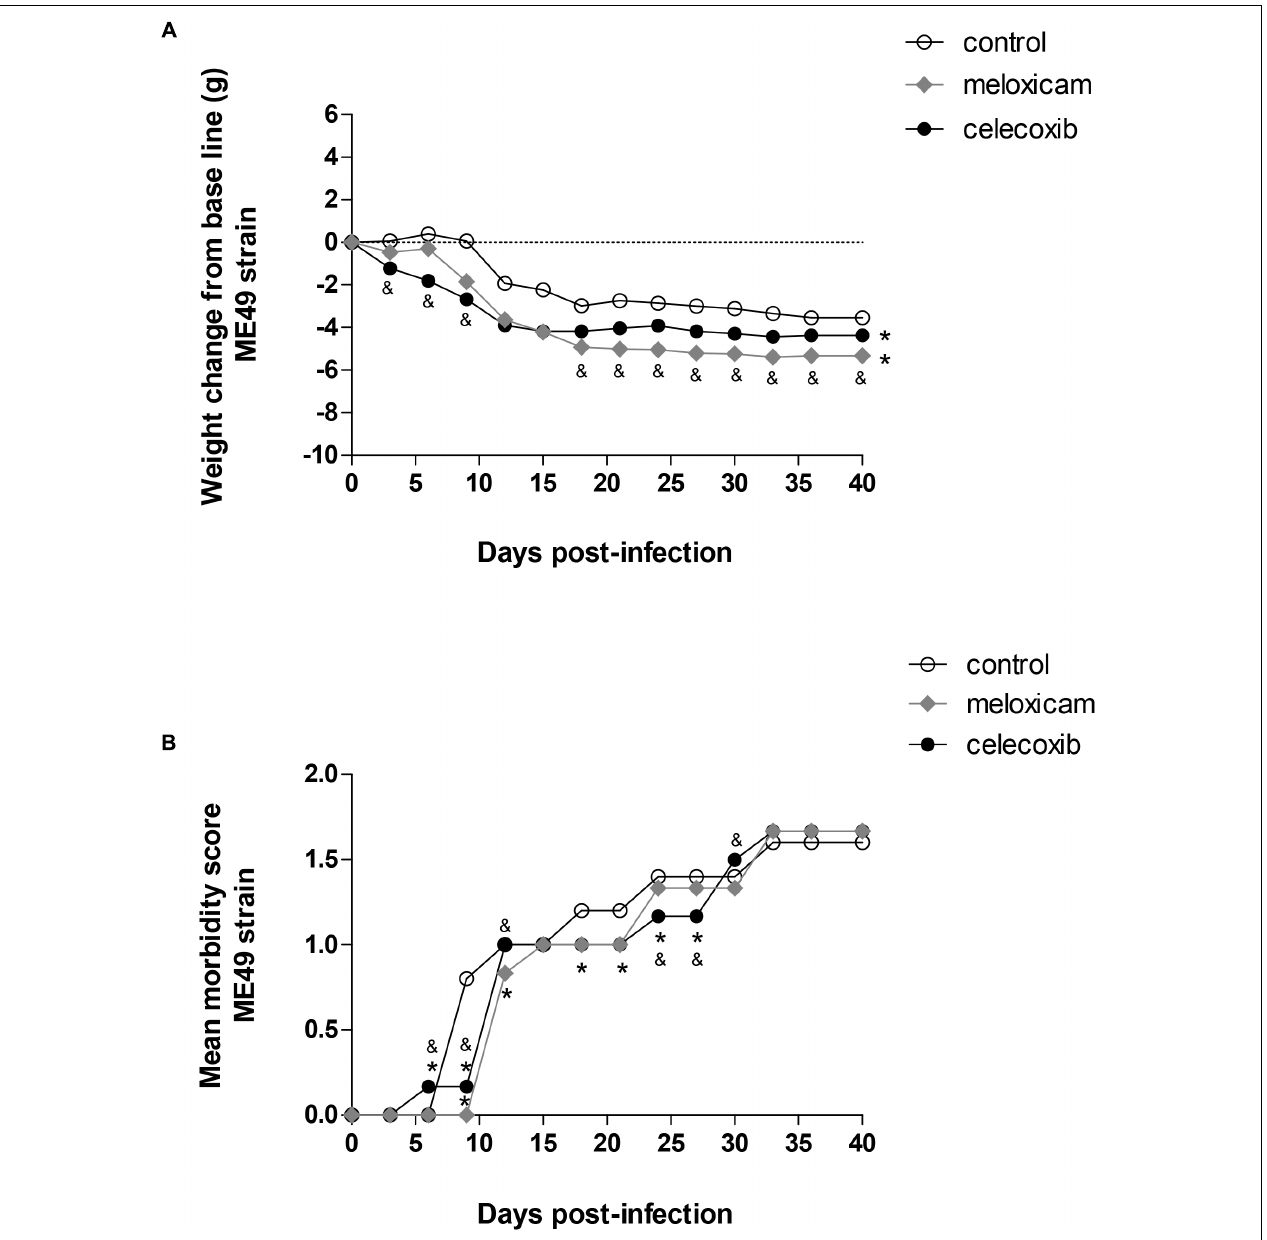
FIGURE 1 | Body weight change and score morbidity. Calomys callosus females were infected orally with 50 cysts of Toxoplasma gondii (ME49 strain), treated or untreated with meloxicam (0.5 mg/kg) or celecoxib (5 mg/kg) daily and monitored for body-weight change (A) and morbidity score (B) for 40 days. Dotted lines represent the absence of body-weight change (A) . Differences between groups were verified by Mann–Whitney test. Significant differences from day 3 post-infection (p.i.) to 39 p.i. in relation to untreated/infected animals (control) ( ∗ P < 0.05), and celecoxib/infected animals ( & P <